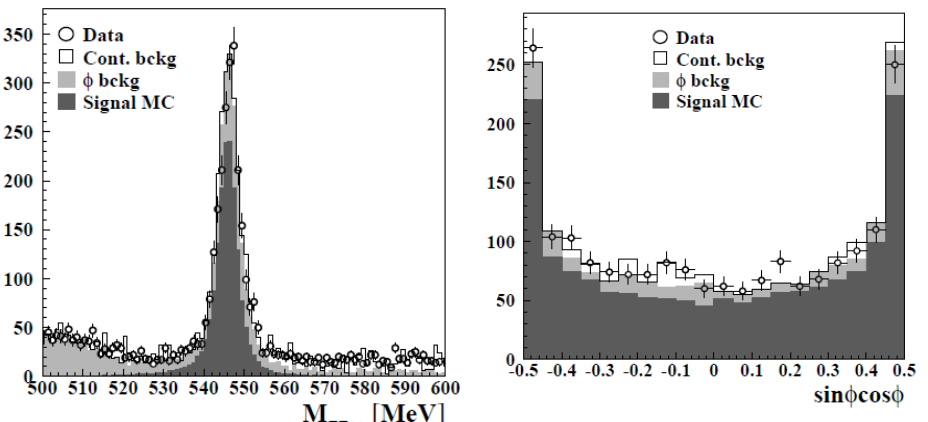
Fig. 3. Right:  +  − e + e − invariant mass spectrum zoomed around the  meson mass. Left: distribution of the sin  ·cos  variable in the signal region. For both histograms dots represent data, the black histogram is the expected distribution, i.e. signal simulation (dark grey),  background (light grey) and continuum background (white).